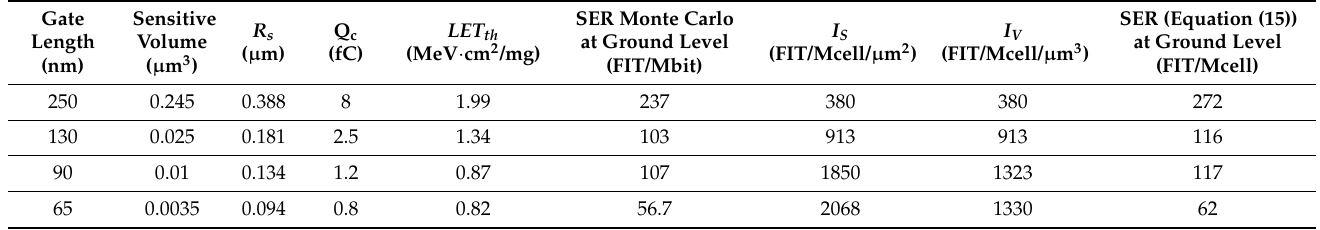
Table 2. Comparison of SER at ground level between the Monte Carlo method and the presented